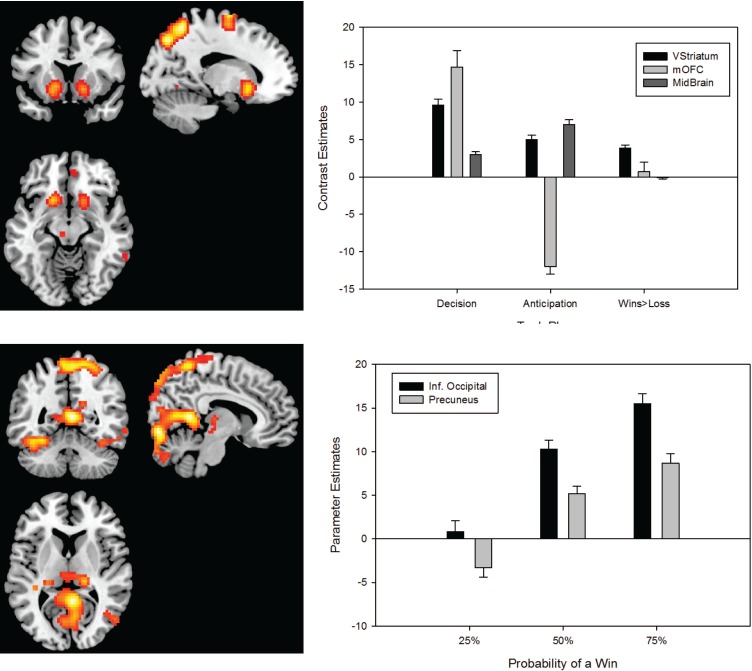
Upper Panel: Brain regions identified as displaying sensitivity to the task phases (i.e. decision, anticipation, wins and losses) in the placebo group (left panel).Parameter estimates for key dopaminergic and reward-related areas showing a significant main effect of task (right panel). Lower Panel: Brain regions where BOLD signal was modulated by reward probability the placebo group (left panel). Parameter estimates from the occipital cortex and precuneus, regions that display a significant main effect of reward probability. All parameter estimates reflect the mean response in arbitrary BOLD units. Results are shown with the standard error of the mean.